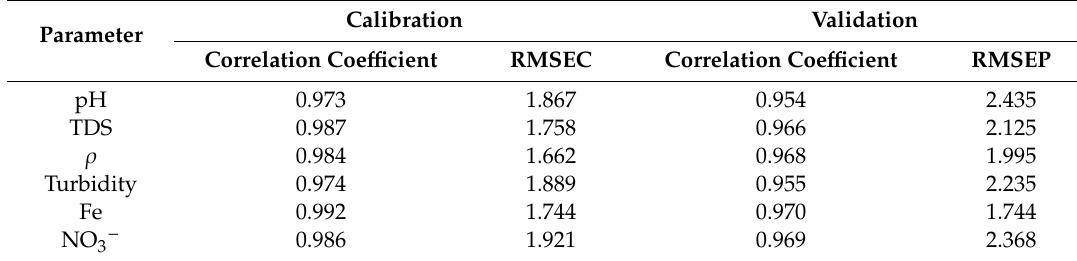
Table 5. Results of PLS1 regression